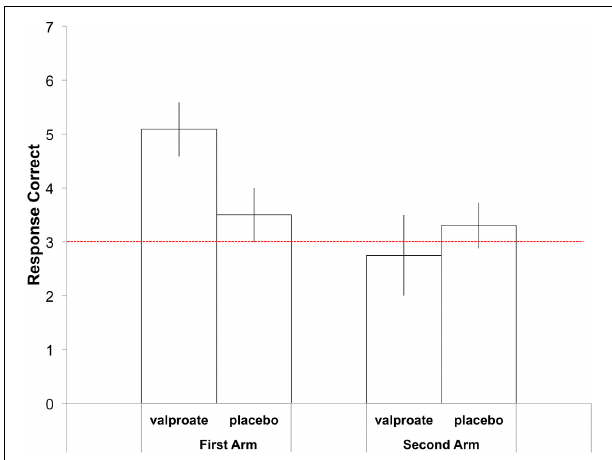
FIGURE 2 | Average number of correct responses in the AP task in the first (left) and second (right) treatment arm. Errors bars indicate the standard error of the mean. The dashed red line indicates chance performance.